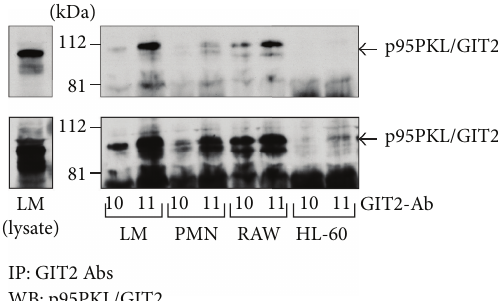
Figure 2: Expression of GIT2 in immune cells. RAW264 macrophages (1.5 × 10 7 cells), human PMNs (3 × 10 7 ), human lymphocytes/monocytes (LM, 3 × 10 7 ), and dimethyl sulfoxide- differentiated HL-60 cells (3 × 10 7 ) were mixed with an equal volume of boiling denaturing buffer and cell lysates were processed essentially as described by Marcil et al. [19]. The supernatants were then filtered through Sephadex G-10 columns to remove the denaturing agents and 0.1% Nonidet P-40, 20 𝜇 g/mL aprotinin, 20 𝜇 g/mL leupeptin, and 5 𝜇 L of bovine serum albumin (0.01% w/v) were added to the eluates. Samples were precleared with protein A-Sepharose and subsequently used for overnight immunoprecipitation with the polyclonal GIT2 antibodies 10 and 11 (5 𝜇 L). The beads were washed three times with ice- cold nondenaturing lysis buffer containing 1% Nonidet P-40 and boiled for 7min at 100 ∘ C in 2x Laemmli’s sample buffer as described previously [19]. Immunoprecipitated proteins were electrophoresed on 10% SDS-PAGE and proteins were transferred to Immobilon PVDF membrane (Millipore Corp., Bedford, MA, USA). Membranes were incubated with the p95PKL/GIT2 antibody (P94020; 1 :1500) from Bection Dickinson (Mississauga, ON, Canada) and exposed to peroxidase-conjugated anti-rabbit IgG (1: 20,000) for 1 h at 37 ∘ C. The membranes were covered with ECL+ detection reagents. Images were obtained by exposing Kodak X-Omat film to membranes for 20 sec (upper panel) and 5 min (lower